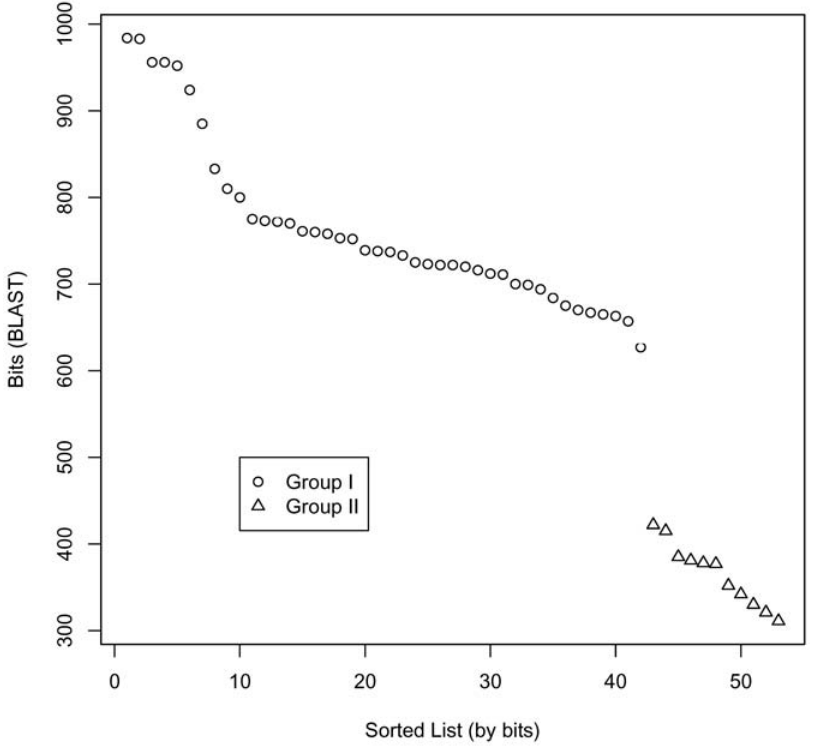
Figure 1. Plot of BLAST bit scores for NifD sequences relative to Nostoc sp. NifD. The Nostoc sp. NifD sequence was used as a query sequence for BLAST against all Group I (triangle) and II (circle) sequences from Table 1 and 2. Each point represents a BLAST result (in bits on the y- axis) and all points are sorted on the x-axis by the bit value. doi:10.1371/journal.pone.0006136.g001 PLoS ONE |